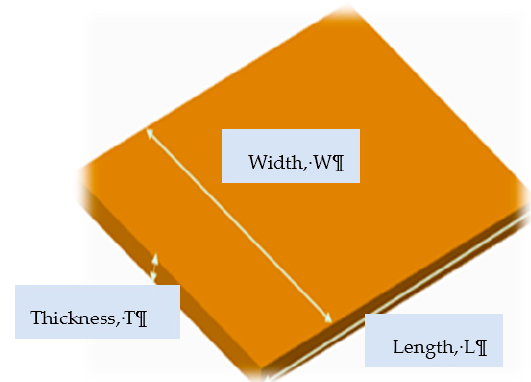
Figure 2. Stress–strain curve for: ( a ) 2.15 mm 2219 Al, ( b ) 4 mm 1060 Al, ( c ) 3 mm Cu, and ( d ) 1.65 mm Cu.